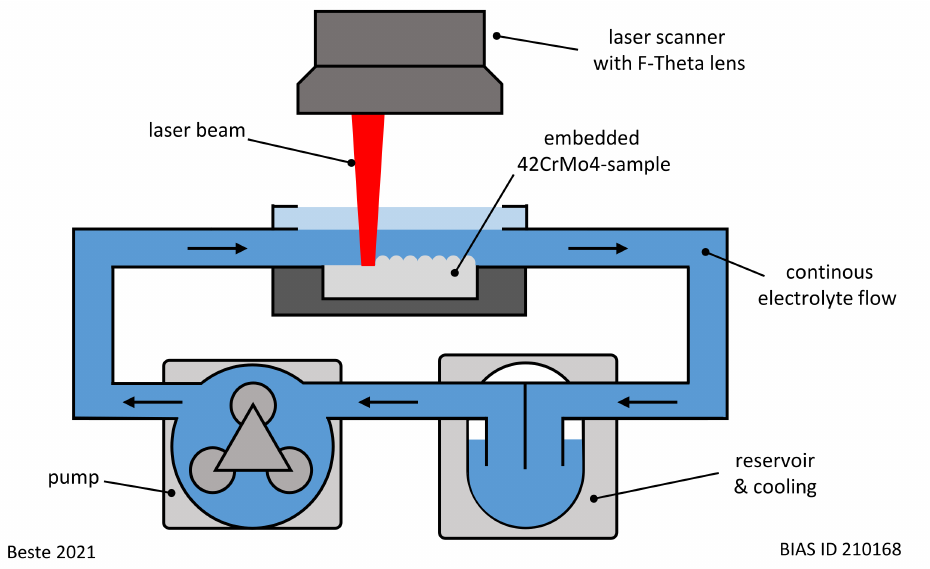
Figure 1. Experimental setup used for LCM.